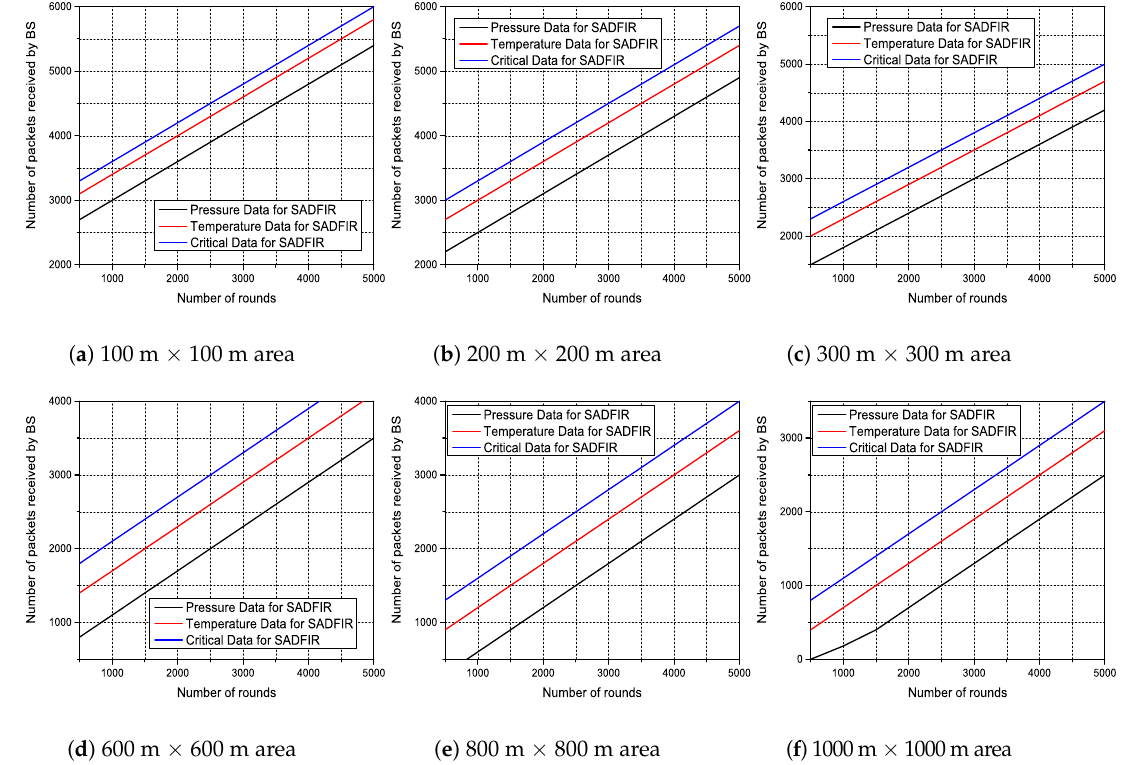
Figure 12. Multi-type data received at BS over network operations in different numbers of network